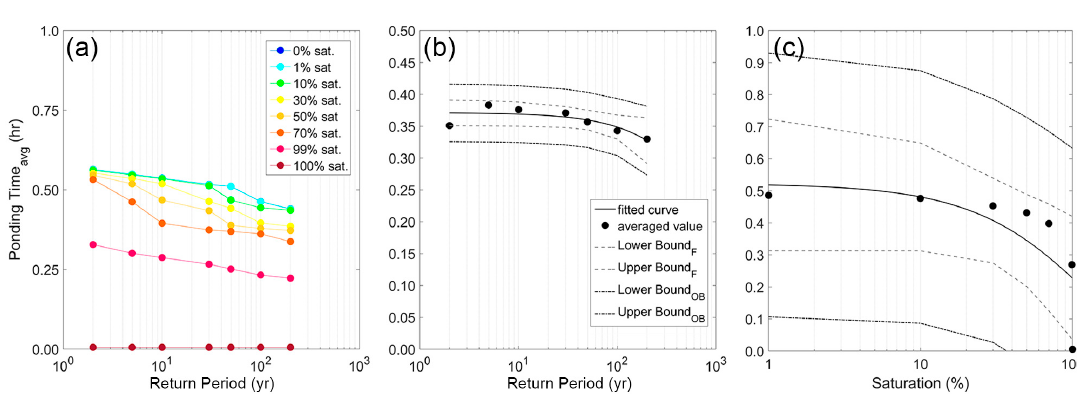
Table 3. Fitted coefficients, 95% confidence intervals (CI 95 ) and goodness of fit (R 2 and Root Mean Square Error—RMSE) for Equation (4) when considering the ponding time (PT) as a function of the return period or the saturation condition.